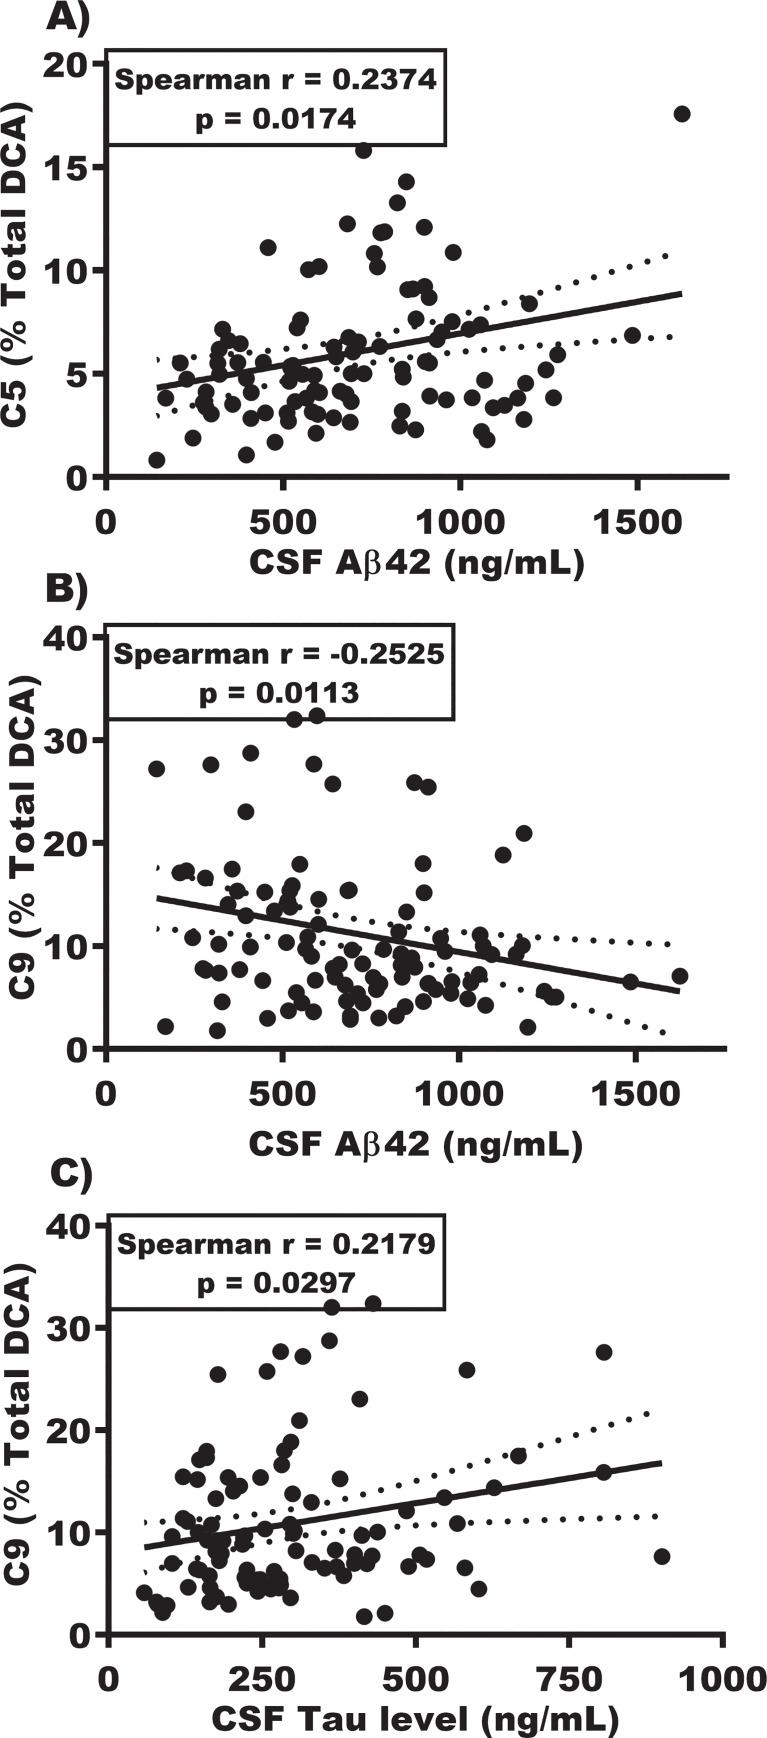
Correlation of urine DCA with CSF markers.A) Correlation of the proportion of (% Total) of C5 (glutaric acid) with CSF Aβ42. B) Correlation of the percentage of C9 (azelaic acid) with CSF Aβ42. C) Correlation of the percent C9 (azelaic acid) with CSF total Tau.